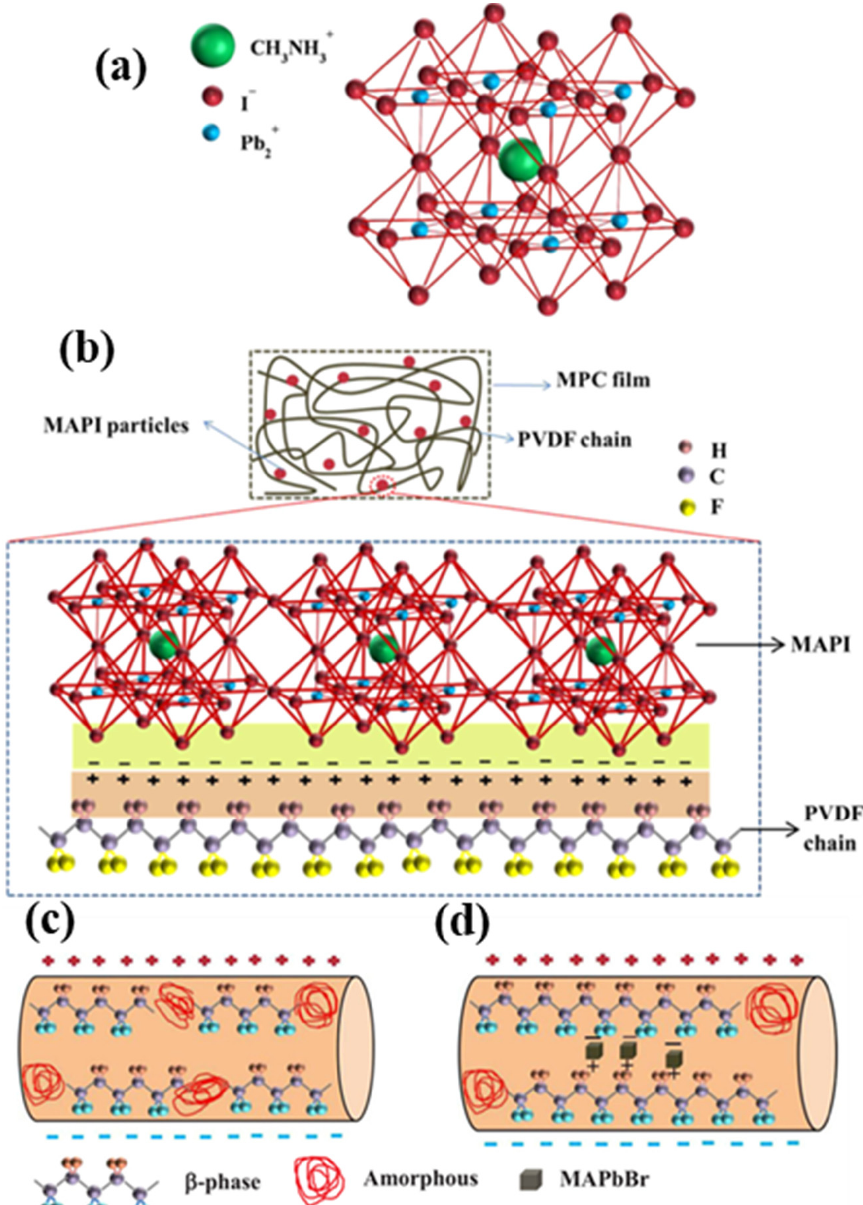
Figure 3. ( a ) The crystal structure of the MAPI perovskite [41]. ( b ) Schematic of the formation mechanism of the electroactive phase in the MAPbI 3 /PVDF composite film [41]. ( c , d ) Schematics of the polarization process of the pure PVDF and the MAPbBr 3 /PVDF composite [42]. Reproduced with the permission from references. [41,42].